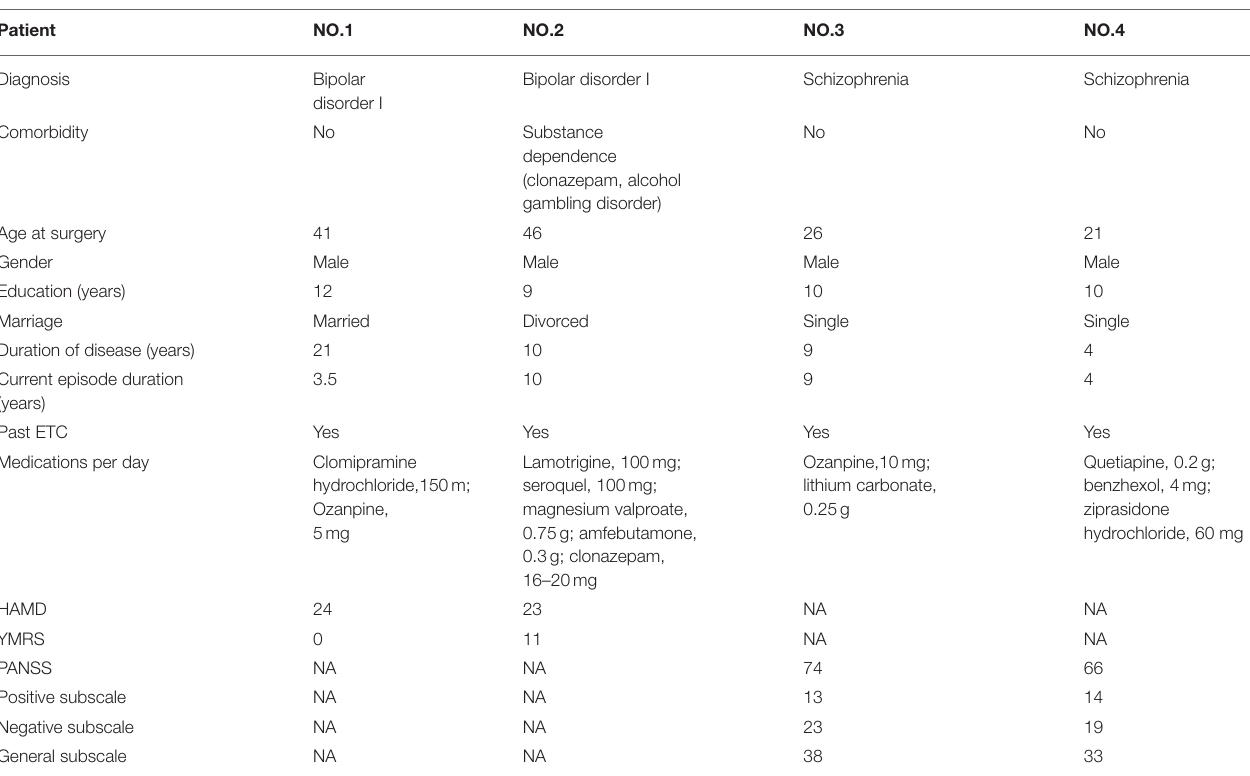
TABLE 3 | Demographic and clinical